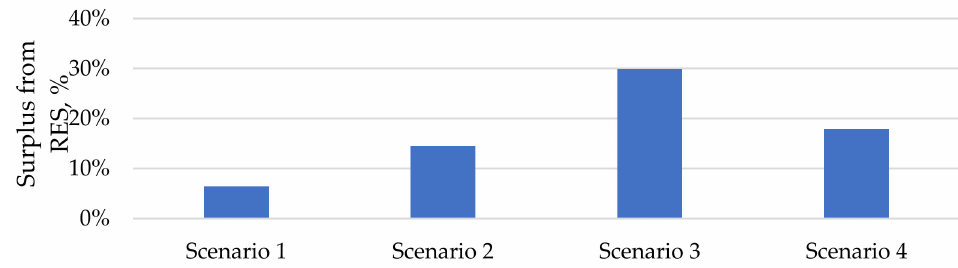
Figure 16. Percentage of surplus from total VRE power.